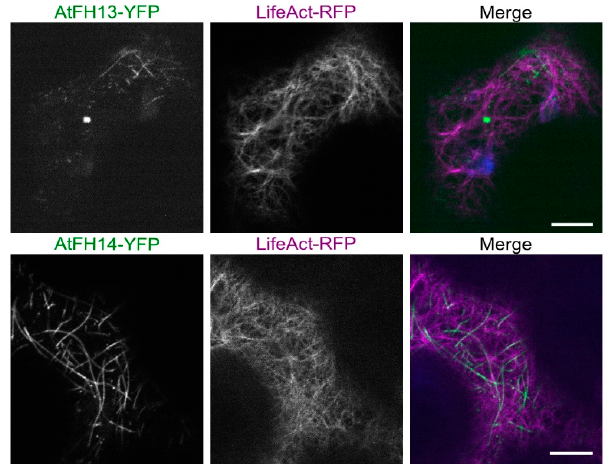
Figure 3. Single optical sections of epidermal cells co-expressing AtFH13-YFP or AtFH14-YFP with the actin marker LifeAct-RFP. Images from single channels are shown in grayscale, merged images display an overlay of three channels represented by green (YFP), magenta (RFP), and blue (chloroplast autofluorescence). Scale bars are 10 µm. Construct abbreviations are defined in the text and in Figure 1.